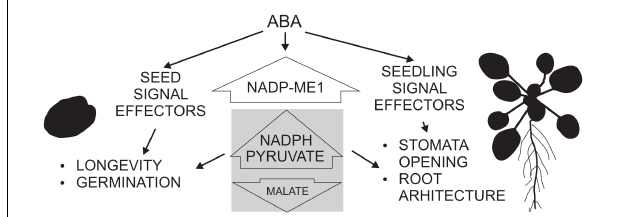
FIGURE 6 | Schematic scheme showing the participation of NADP-ME1 in ABA response in Arabidopsis. ABA induces NADP-ME1 expression in particular organs and cell types producing a modification of malate, pyruvate, and NADPH levels, which impact on seed longevity and germination, stomata opening and root